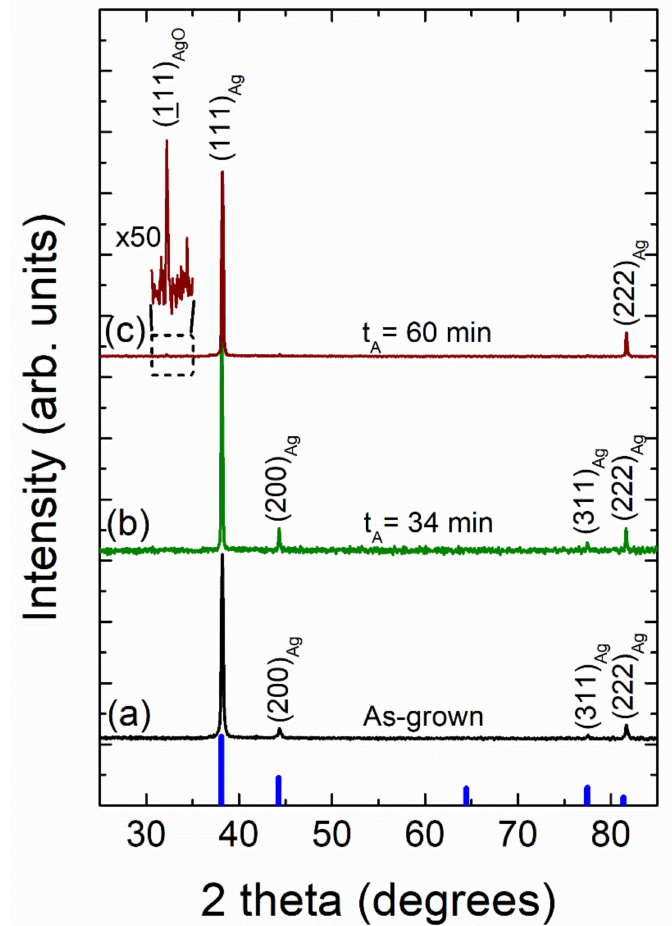
Figure 12. X-ray diffraction patterns of vacuum-thermal-evaporated silver layers with a nominal thickness d Ag = 80 nm at different stages of the annealing step of the SSD process by applying the constant temperature region program depicted in Figure 1 at T A = 500 ◦ C and ending at different t A values: ( a ) as-grown silver layer, ( b ) t A = 34 min, and ( c ) t A = 60 min. Miller indices ( hkl ) for cubic silver diffraction planes are indicated. Cubic Ag JCPDS pattern is also shown for comparison (thick blue bars). The zoom of the pattern ( c ) in the 2 theta region from 30 to 35 degrees depicts a diffraction peak corresponding to the AgO phase. Temperature ramp rate =10 ◦ C /min. In all of these cases, a soda lime glass substrate has been